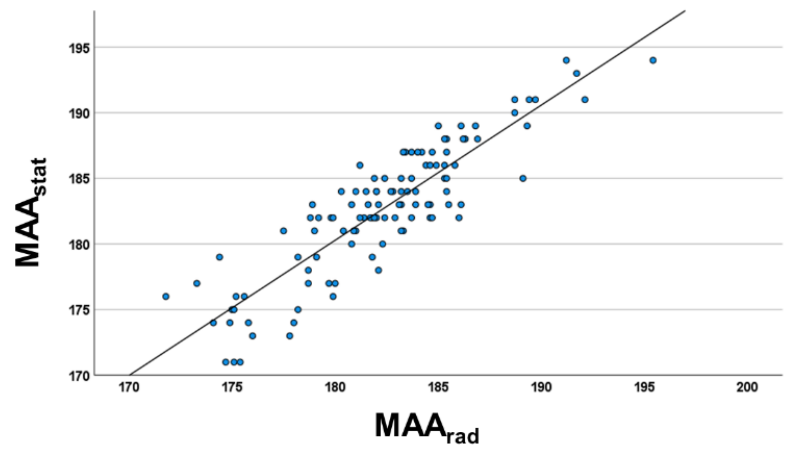
Figure 2. Scatter diagram of the relationship between radiographic femorotibial mechanical axis in frontal plane (MAA rad ) and marker-based static full leg analysis (MAA stat ) (r s = 0.858; p < 0.001) of the study cohort ( n = 102). Regression equation: MAA rad = 1.03 MAA stat — 5.38. The Bland–Altman plot analysis of the marker-based static leg axis analysis vs. X-ray